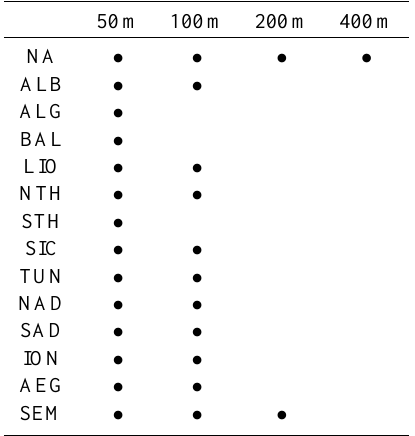
maxima south of Portugal (2 m/s) and in the Eastern Mediter- ranean, in correspondence to the Ierapetra gyre (1.6 m/s) and